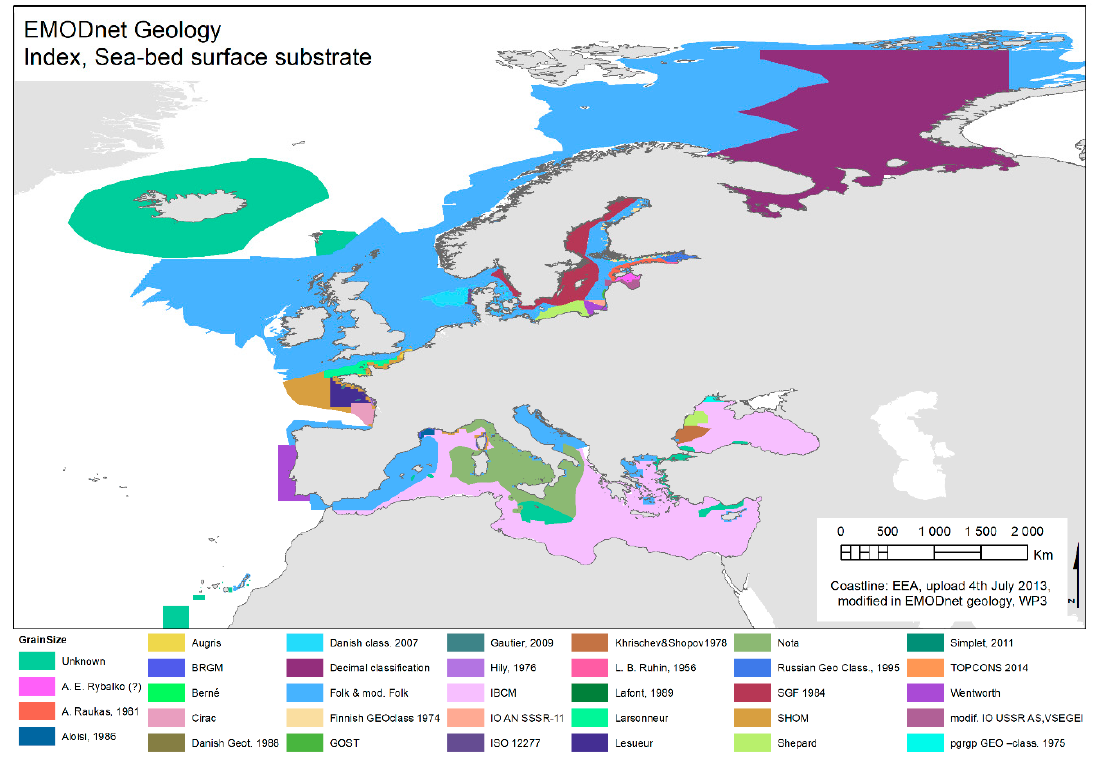
Figure 5. Different grain size classification systems used in seabed mapping by different European contributors participating in EMODnet-Geology. Data indicate more than 30 grain size classification schemes.